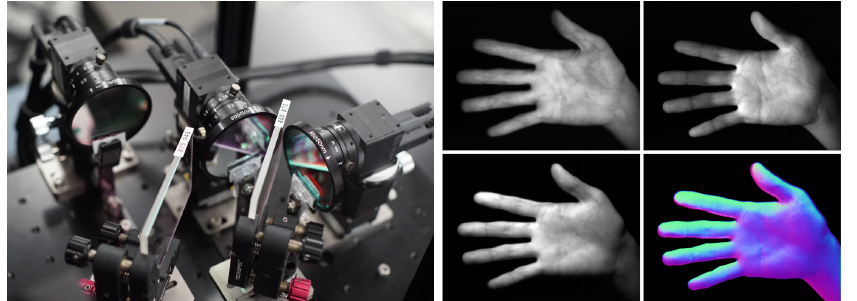
Figure 7. High-speed normal measurement system and normal map calculation by photometric stereo method.